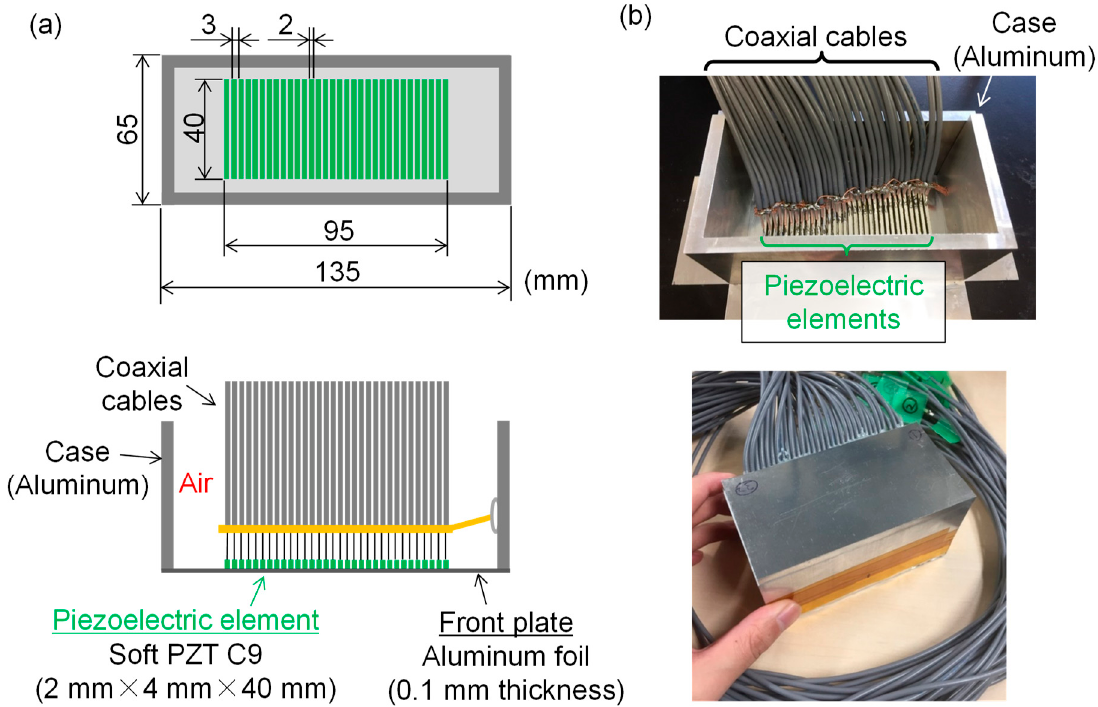
Figure 6. Fabrication of 32-element LF array transducer with the center frequency of 350 kHz. ( a ) Schematic showing the structure of LF array transducer; ( b ) photographs of the fabricated LF array transducer.